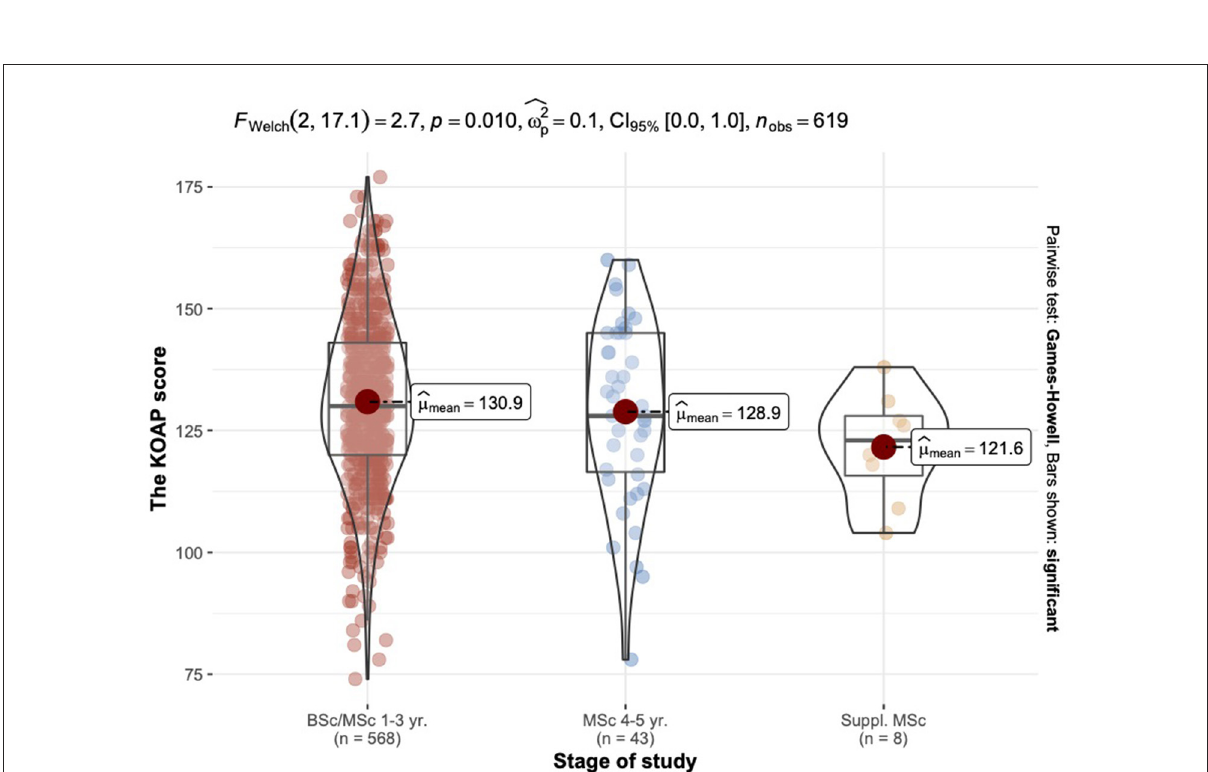
FIGURE4 Comparative characteristics of the KAOP mean scores grouped by study